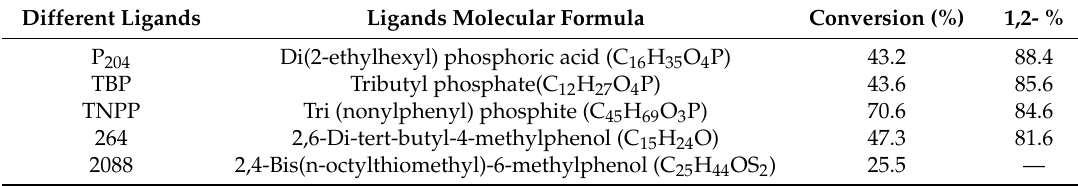
Table 1. The effect of different types of ligands on polymerization activity and microstructure. Different Ligands Ligands Molecular Formula